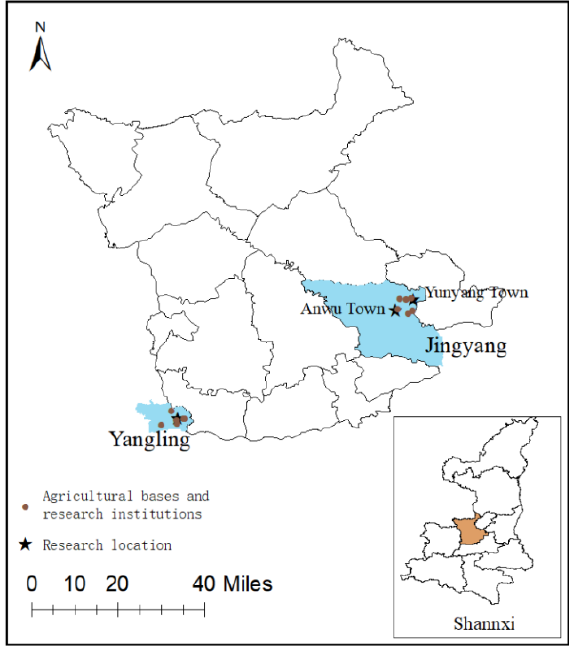
Figure 3. Areas and locations selected for the study.